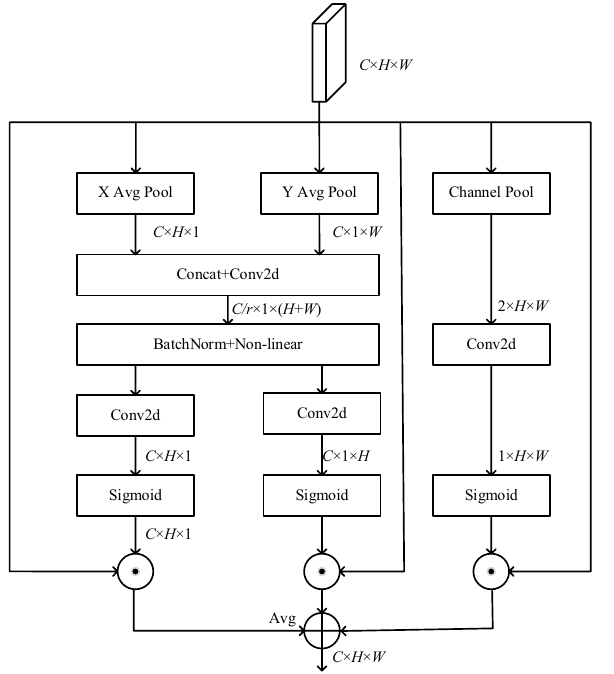
Figure 3. Multiple attention